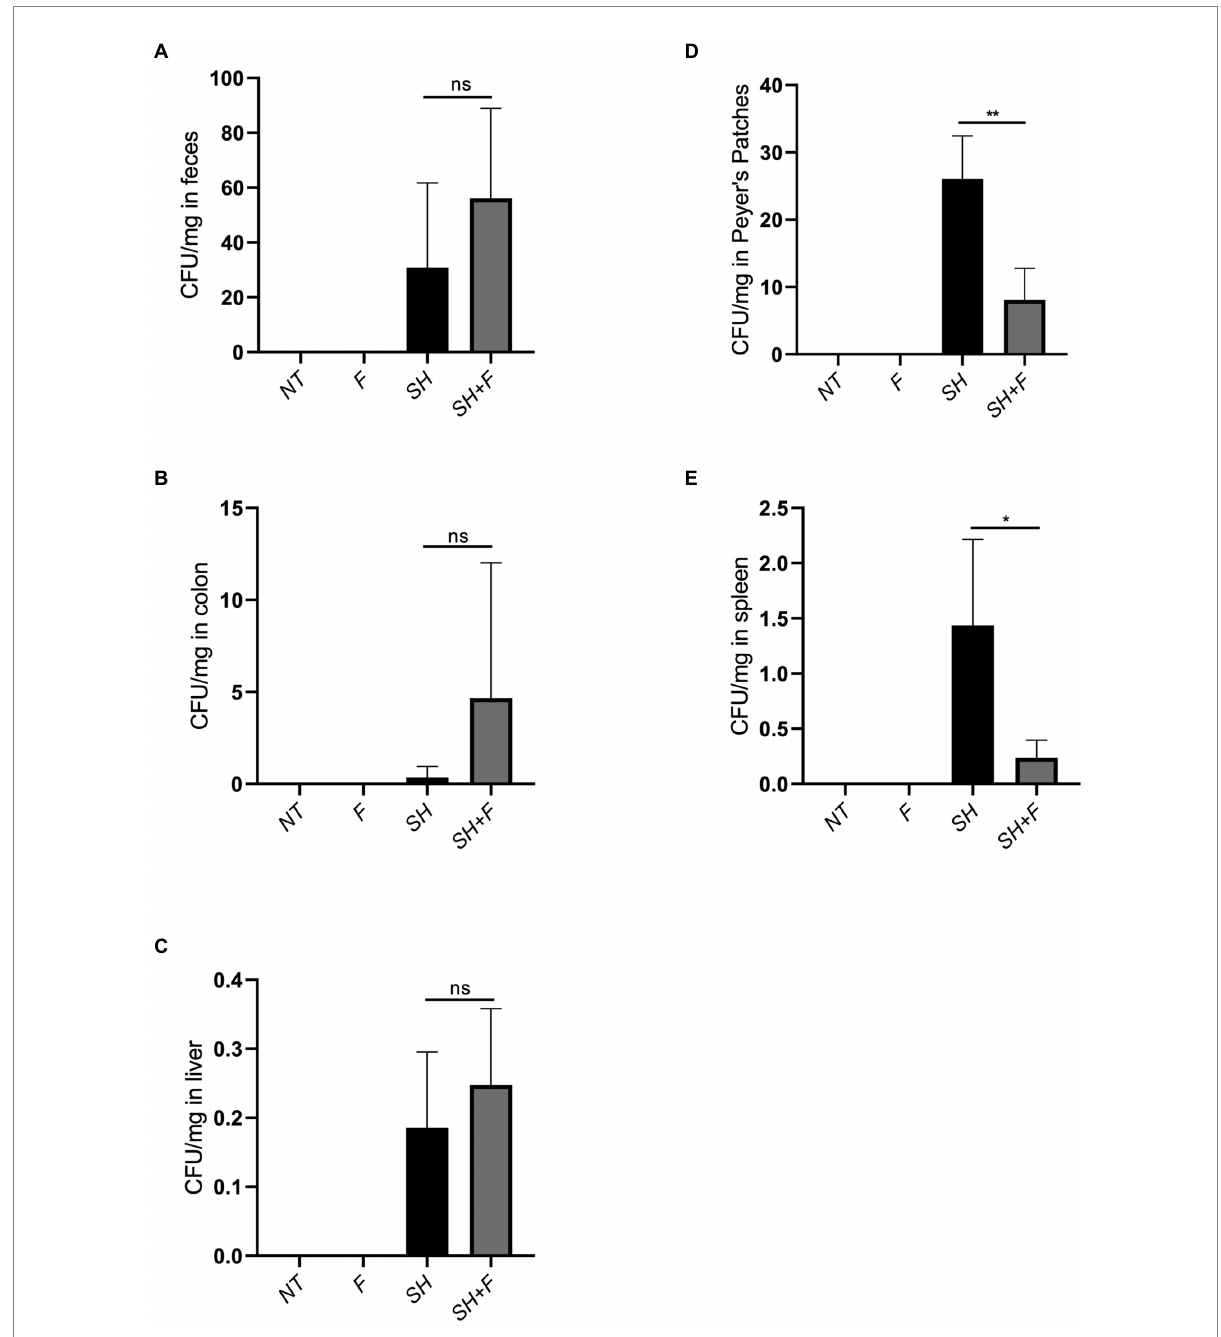
FIGURE 2 The mixture of F3 and F4 decreased translocation of S . Heidelberg in BALB/C mice. Effects of bioactive fractions on bacterial load during Salmonella infection. Several groups were used in the study, untreated mice (NT), mice receiving only Salmonella (SH), mice receiving only fractions (F) and mice receiving both Salmonella and fractions (SH + F). After 8 days of infection, Salmonella was extracted from (A) feces, (B) colon, (C) liver, (D) Peyer’s patches, and (E) spleen, and plated on rapid’ Salmonella chromogenic agar. CFU/mg represented the number of CFU of bacteria recovered per milligram of tissue. The Shapiro test was used to verify Normality. Statistical data were evaluated by the one-way ANOVA test on n = 5. Data were represented by SEM bars, * p < 0.05 , ** p < 0.01 and ns = no